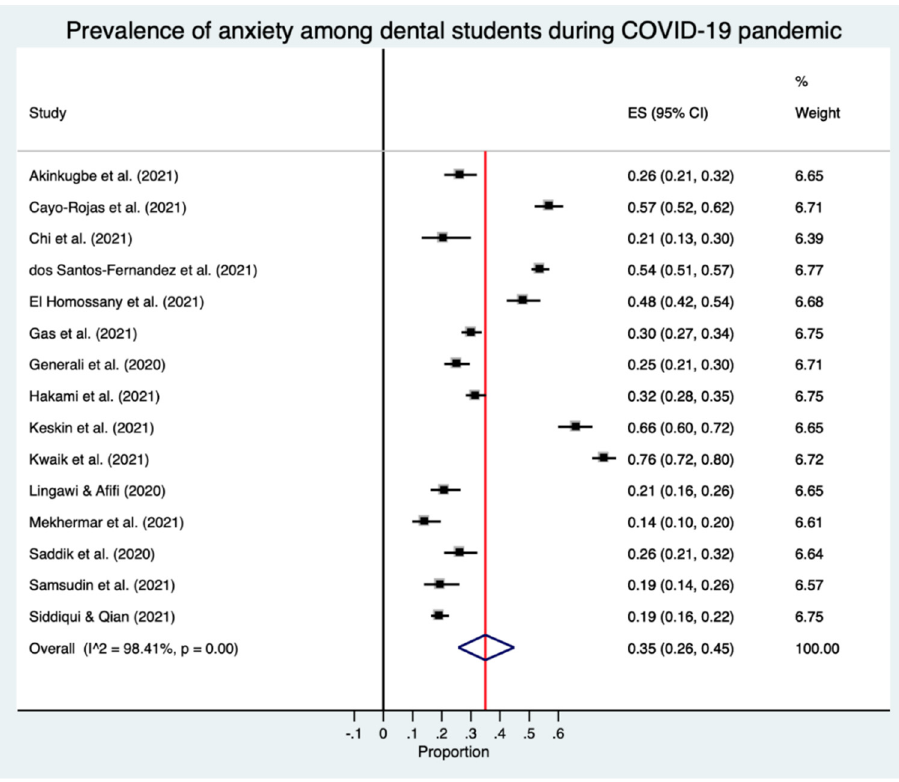
Figure 2. Forest plot for the prevalence of anxiety in dental students.